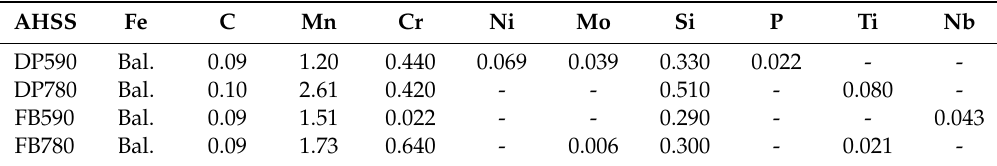
Table 1. Chemical composition of di ff erent advanced high-strength steels (AHSS, wt.%).